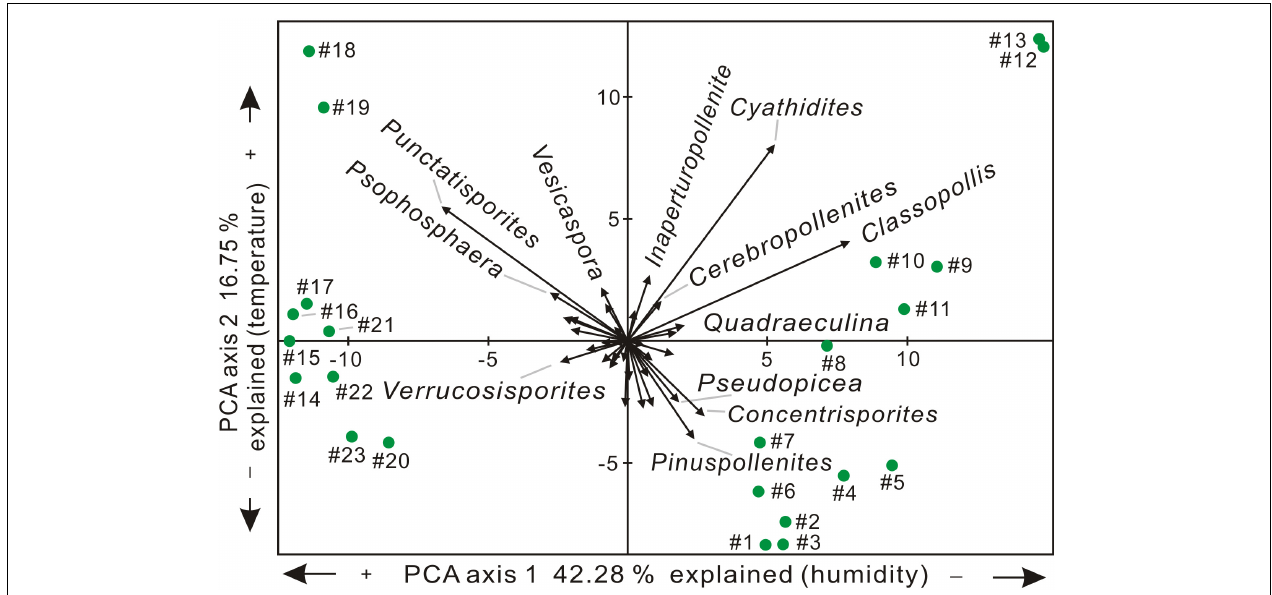
FIGURE 4 | Loading plots of PCA1 and PCA2 for spore and pollen genera (excluding rework taxa) from the studied borehole in the Jiyuan Basin.